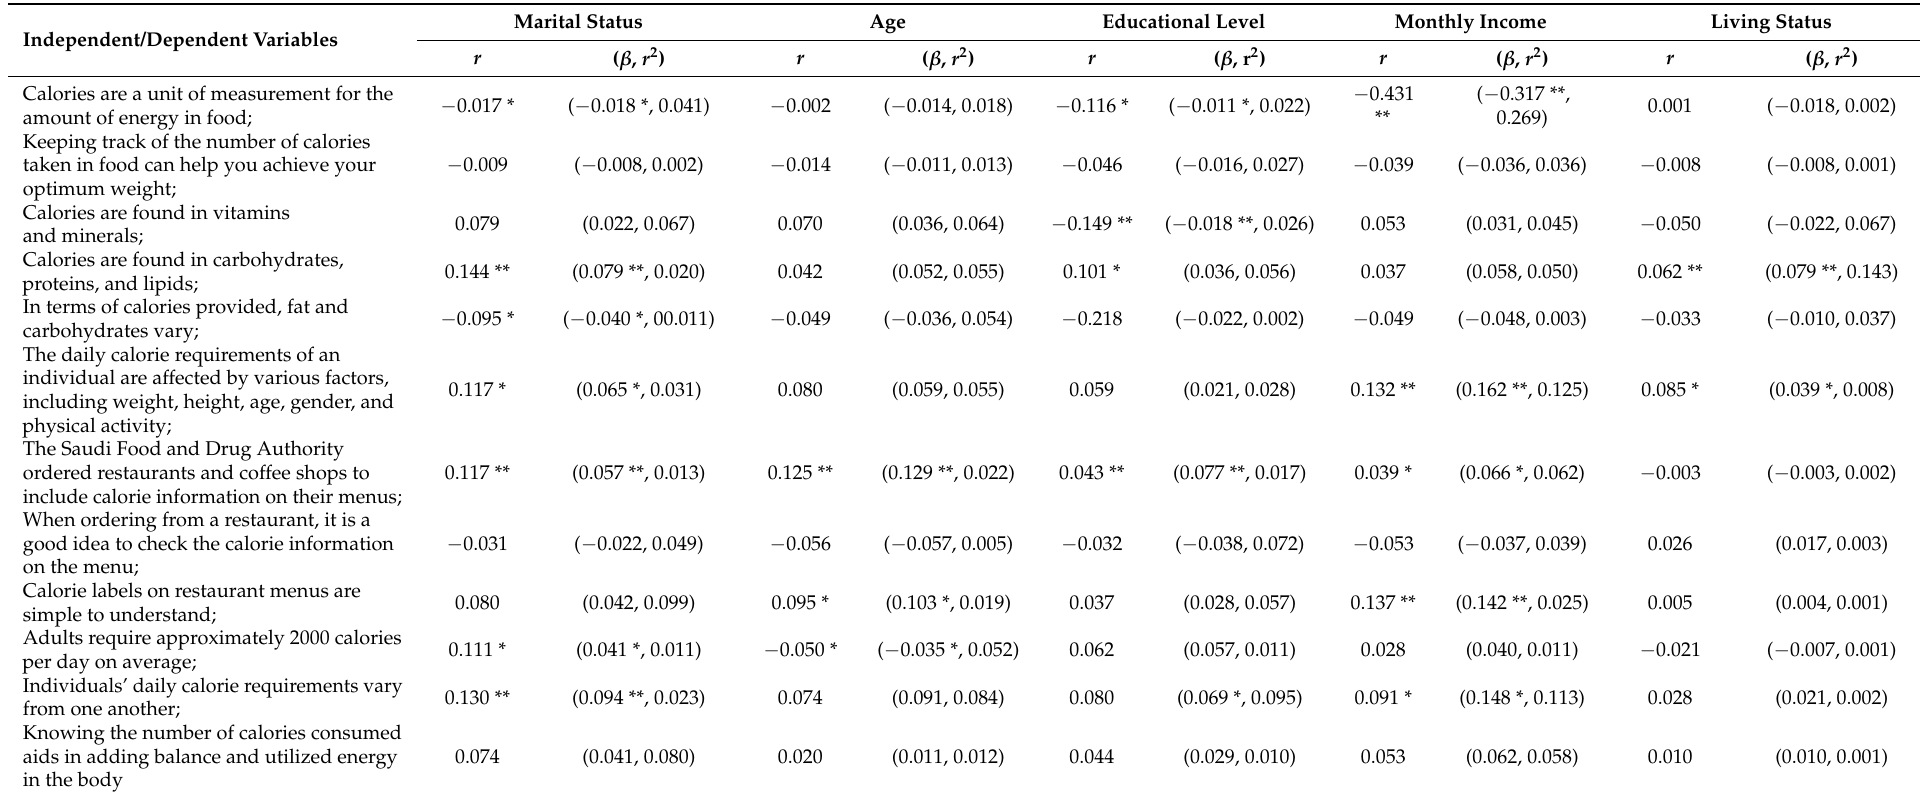
Table 5. Spearman correlation coefficients ( r ) and simple linear regression analysis ( β , r 2 ) between demographic characteristics and food label knowledge for females ( n =